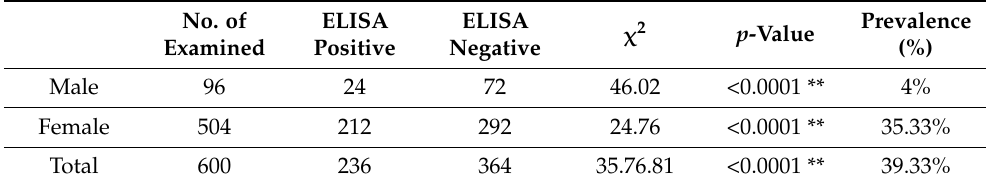
Table 4. Prevalence of leptospirosis in cattle according to sex.